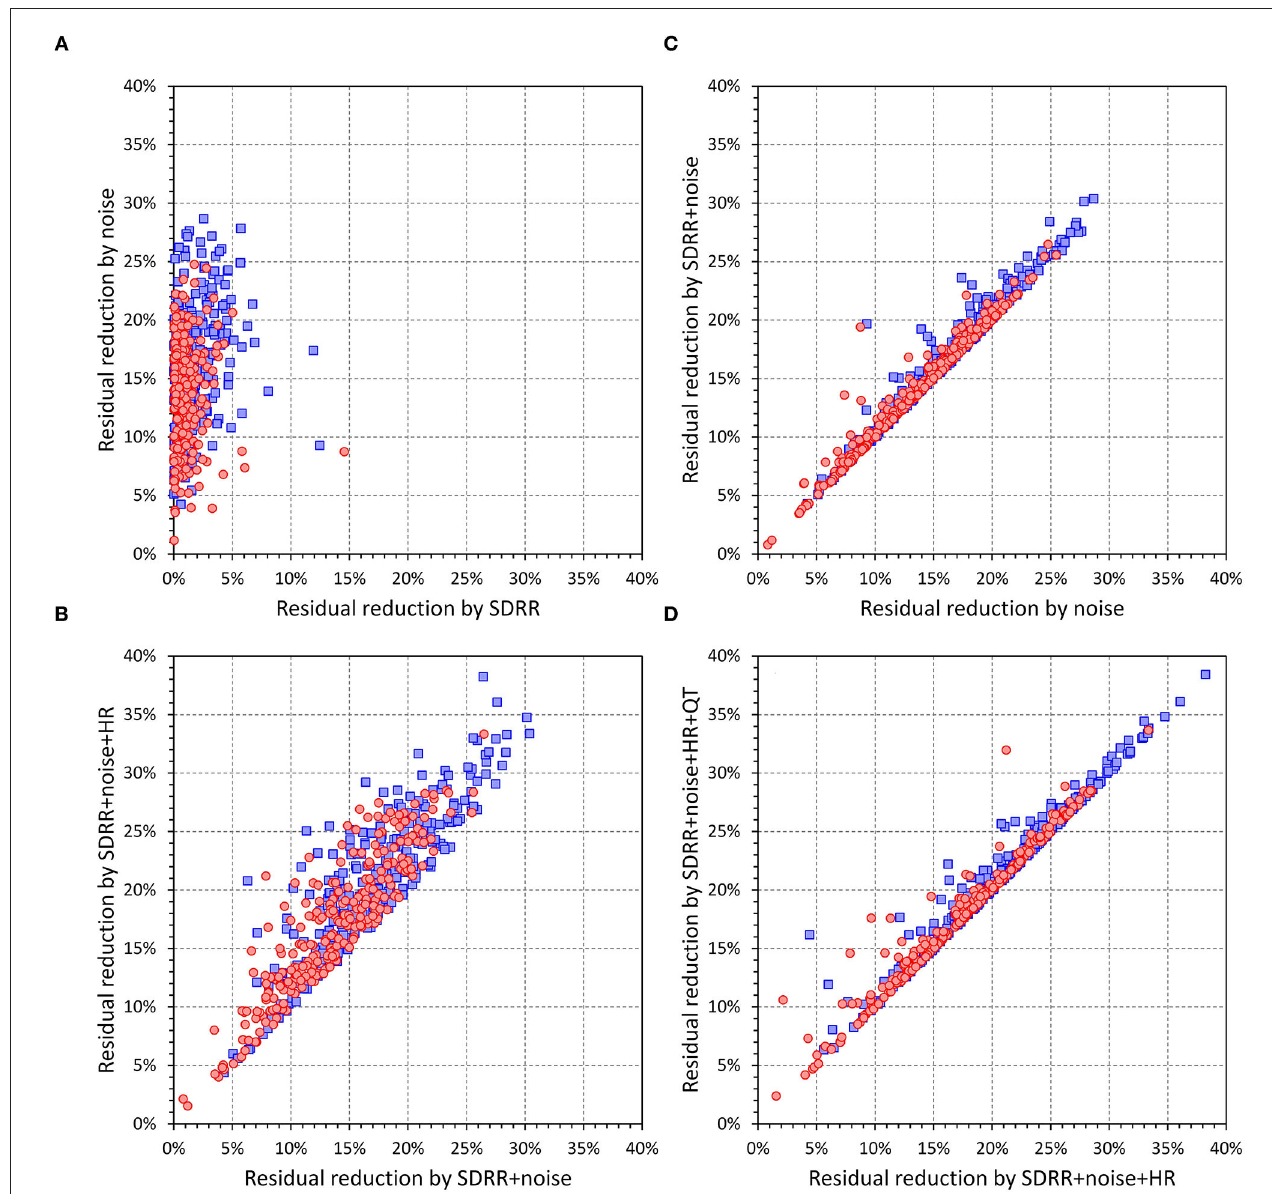
FIGURE 14 | The residual reductions shown in this figure (A–D) are defined as values of relative decrease of intra-subject residuals of linear regressions SDQT calculated as proportions of intra-subject standard deviations of SDQT. Axis labels of SDRR, noise, SDRR + noise, SDRR + noise + HR, and SDRR + noise + HR + QT designate intra-subject residuals of SDQT vs. SDRR; 10-s median beat noise; combination of SDRR and 10-s median beat noise; the combination of SDRR, 10-s median beat noise, and 10-s heart rate; and combination of SDRR, 10-s median beat noise, 10-s heart rate, and 10-s median QT interval duration, respectively. In all panels, red circles and blue squares correspond to females and males,